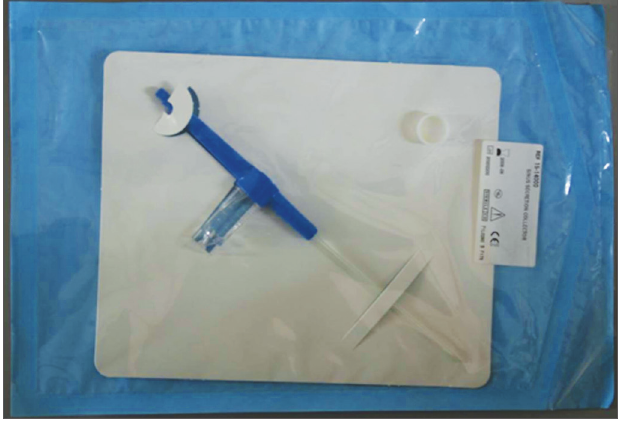
Figura 1. A figura mostra o coletor estéril “suction